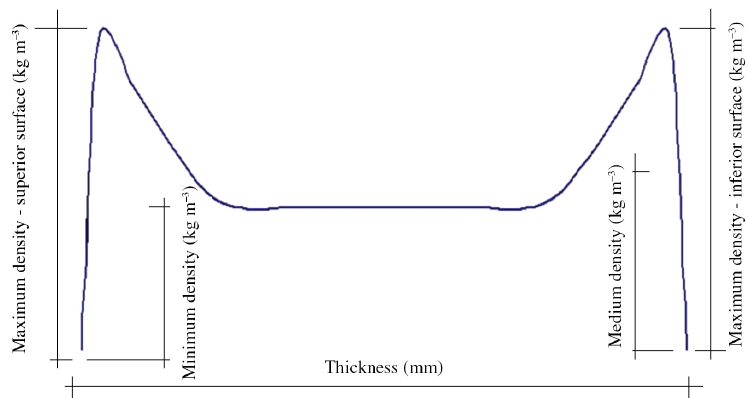
Figure 1. Density profile of panels by X-ray densitometry (A) X-ray densitometer GreCon DA-X, (B and C) cutting the panel samples; (D) samples arranged in the holder; (E) displacement of the support to the reading chamber; (F) profile and density values of the panel.